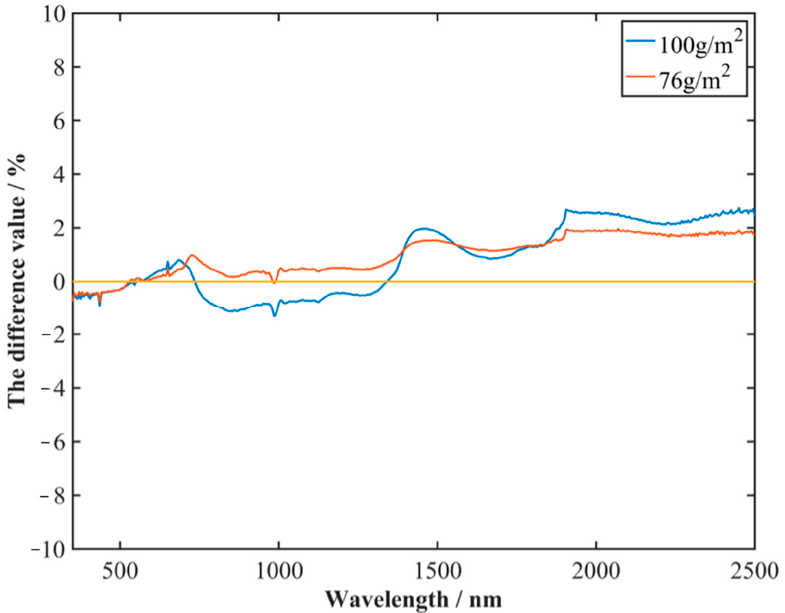
Figure 9. The difference curve between the corrected simulated and the measured values.